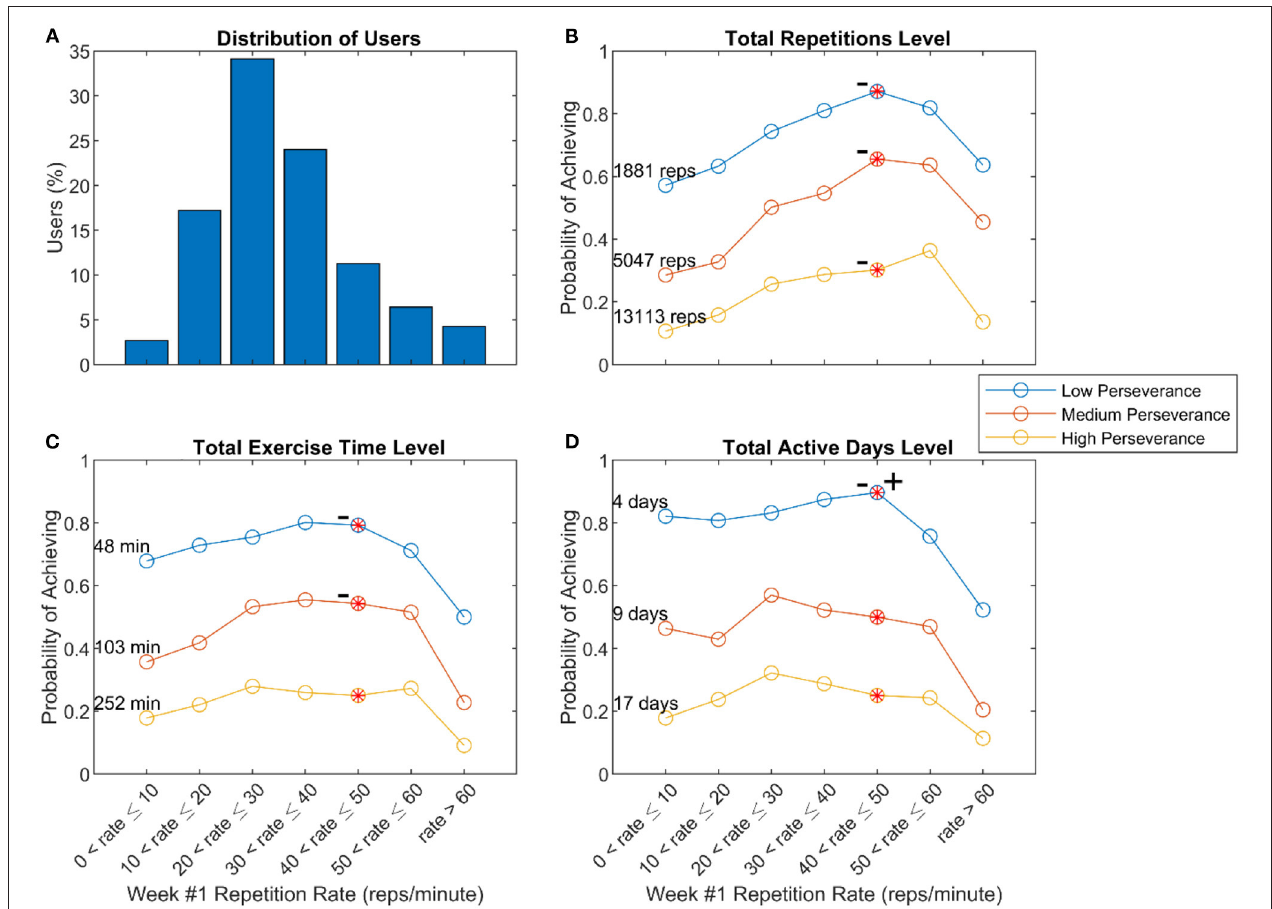
FIGURE 6 | Relationship of repetition rate of the Reach to Target # 2 exercise in Week 1 and perseverance. (A) Distribution of users with various repetition rates (B–D) Probability of achieving low, medium, and high levels of perseverance, defined to be the 25th, 50th, and 75th percentiles of three measures of usage – total repetitions (B) , total exercise time (C) , and total active days (D) – measured across 8 weeks of use. The – symbol indicates a significant decline from the peak value moving to the left, and sign indicates a significant decline from the peak value moving to the right, using the “sweet spot” test described in the methods ( p < +